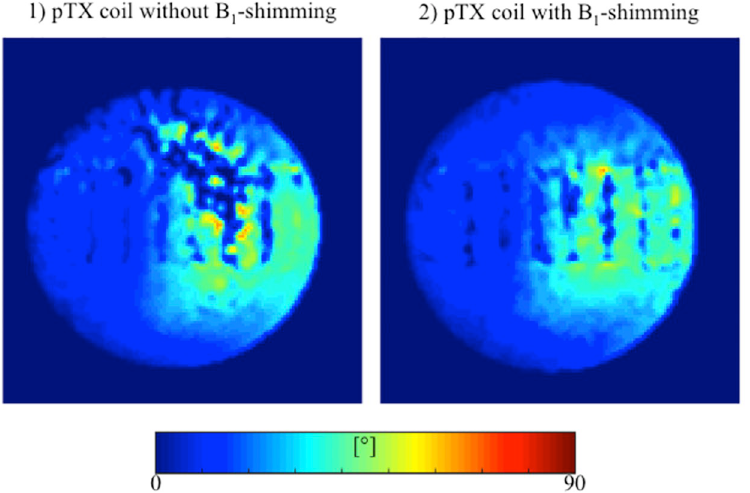
B 1+ -maps were acquired for approximation of the field inhomogeneity. Maps with and without B -shimming are displayed in Fig 3. The map acquired with a pTX coil without B -shimming 1 1 depicts distinct local B 1+ -inhomogeneity in the upper-right quadrant of the thorax phantom. In contrast, the B 1+ -map acquired with B -shimming shows a distinctly more homogenous 1 B 1+ -field distribution, demonstrating the positive impact of the shimming procedure and par- allel transmission.